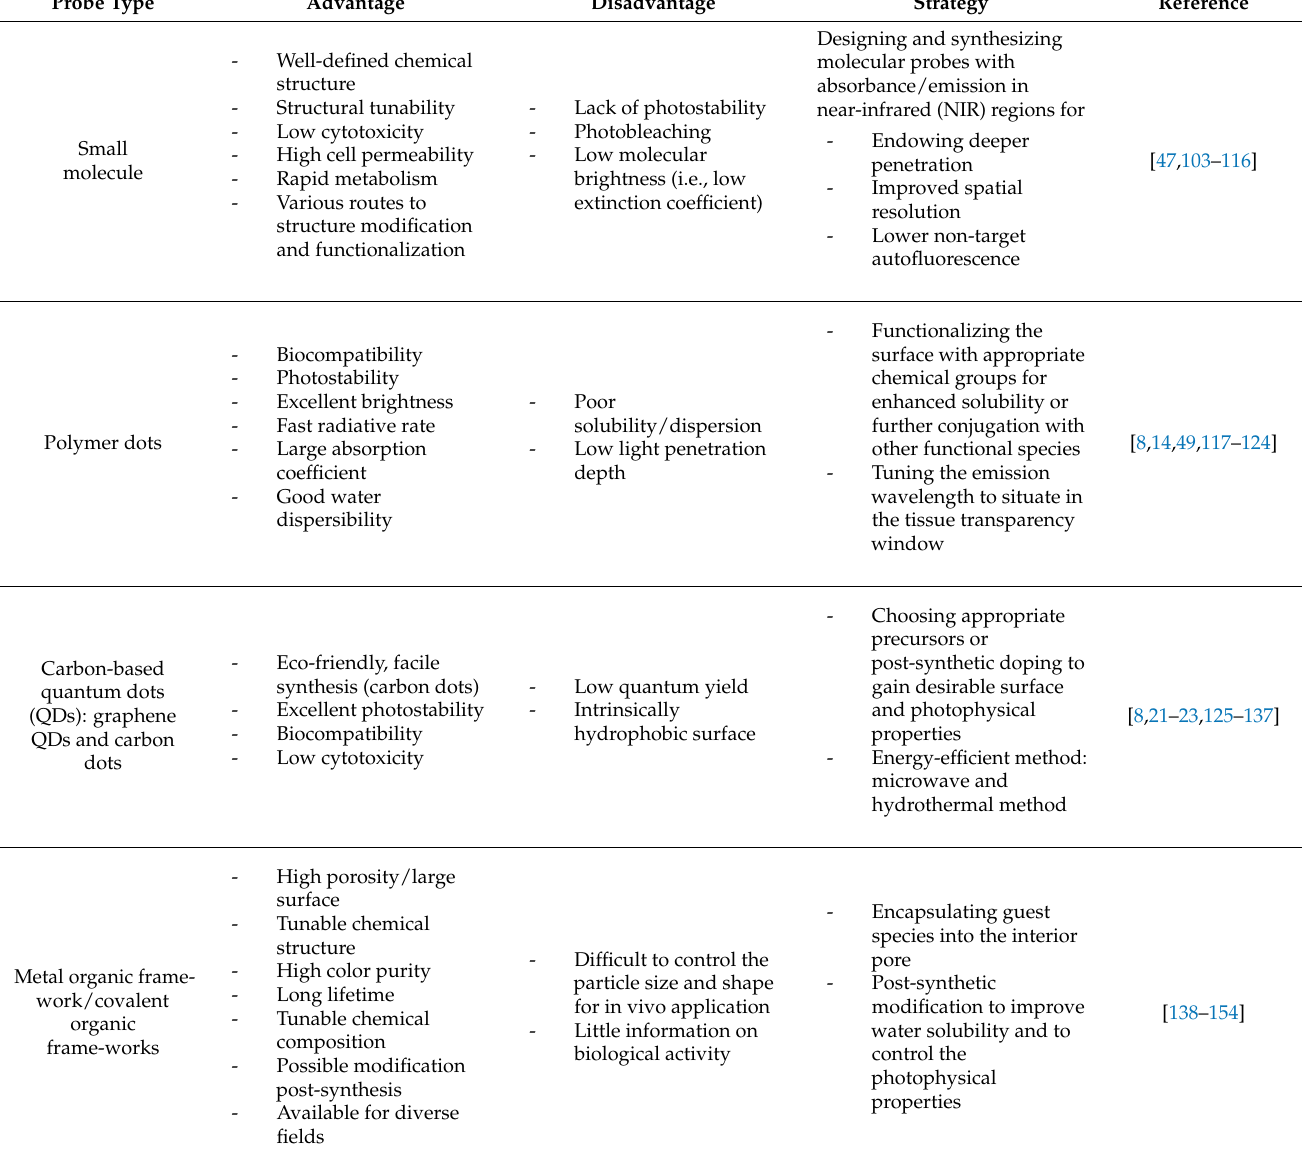
Table 1. Summary of the probes currently used in